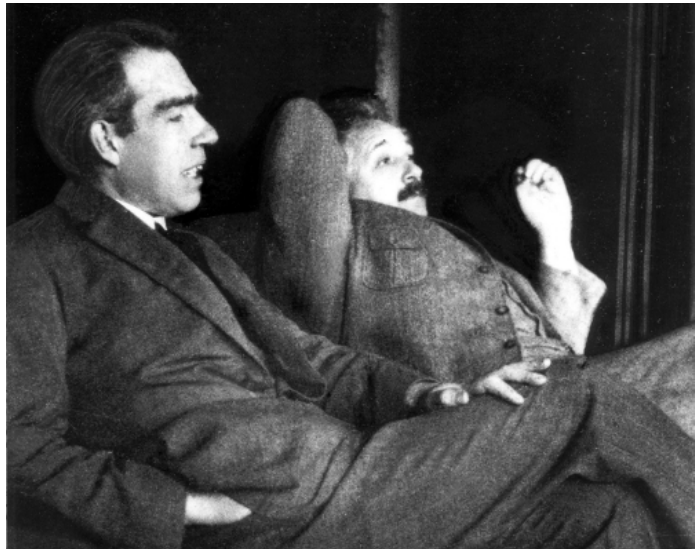
Figure 4. Niels Bohr and Albert Einstein in 1925. Taken from